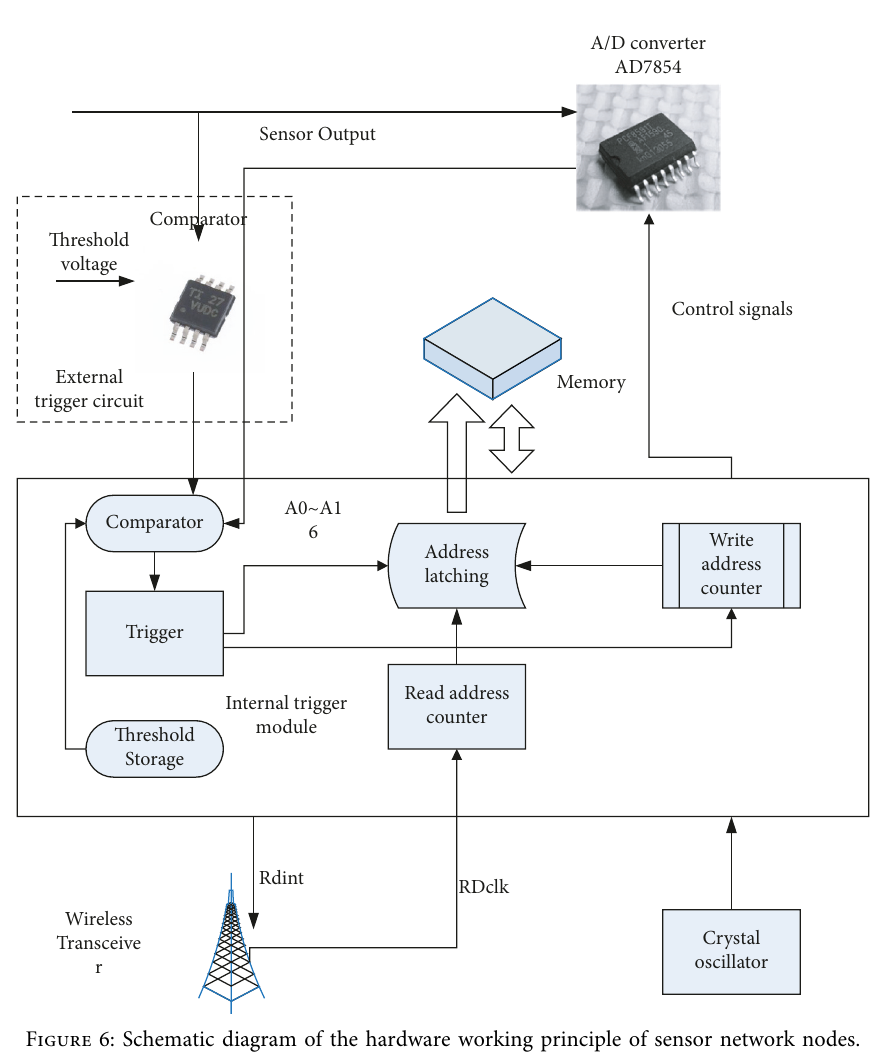
Figure 6: Schematic diagram of the hardware working principle of sensor network nodes.